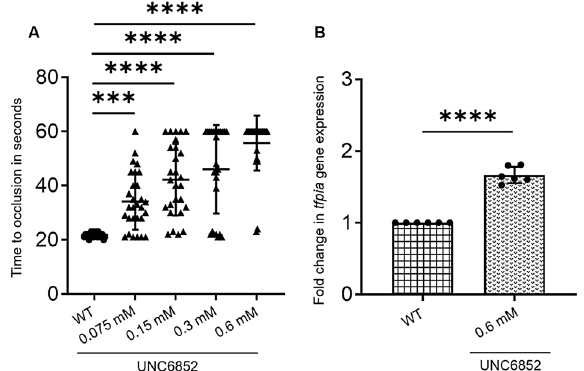
Figure 5. Treatment of zebrafish larvae and adult with a PRC2 inhibitor, UNC6852. ( A ) Comparison of time to occlusion of the caudal vein after laser injury between wild-type control 5 dpf larvae and UNC6852-injected larvae by one-way ANOVA. The x-axis represents four different concentrations of the UNC6852 (0.075 mM, 0.15 mM, 0.3 mM and 0.6 mM) used for larval injections. The dot plots represent wild-type larvae (closed circles) and the knockdown larvae (closed triangles). Error bars represent mean ± SD. 50 larvae each were used in control and UNC6852 injections (N = 50); ( B ) Quantitative real-time PCR showing the fold change of tfpia gene expression in liver and spleen for UNC6852-injected adult zebrafish with wild-type control by Student’s t test. The concentration of UNC6852 used for adult injections (0.6 mM) is indicated beneath the bar graph. Error bars represent mean ± SD. Six fish were used for each of the simultaneous 5-gene knockdown and control experiments (N = 6). *** and **** represent p ≤ 0.001 and p ≤ 0.0001,